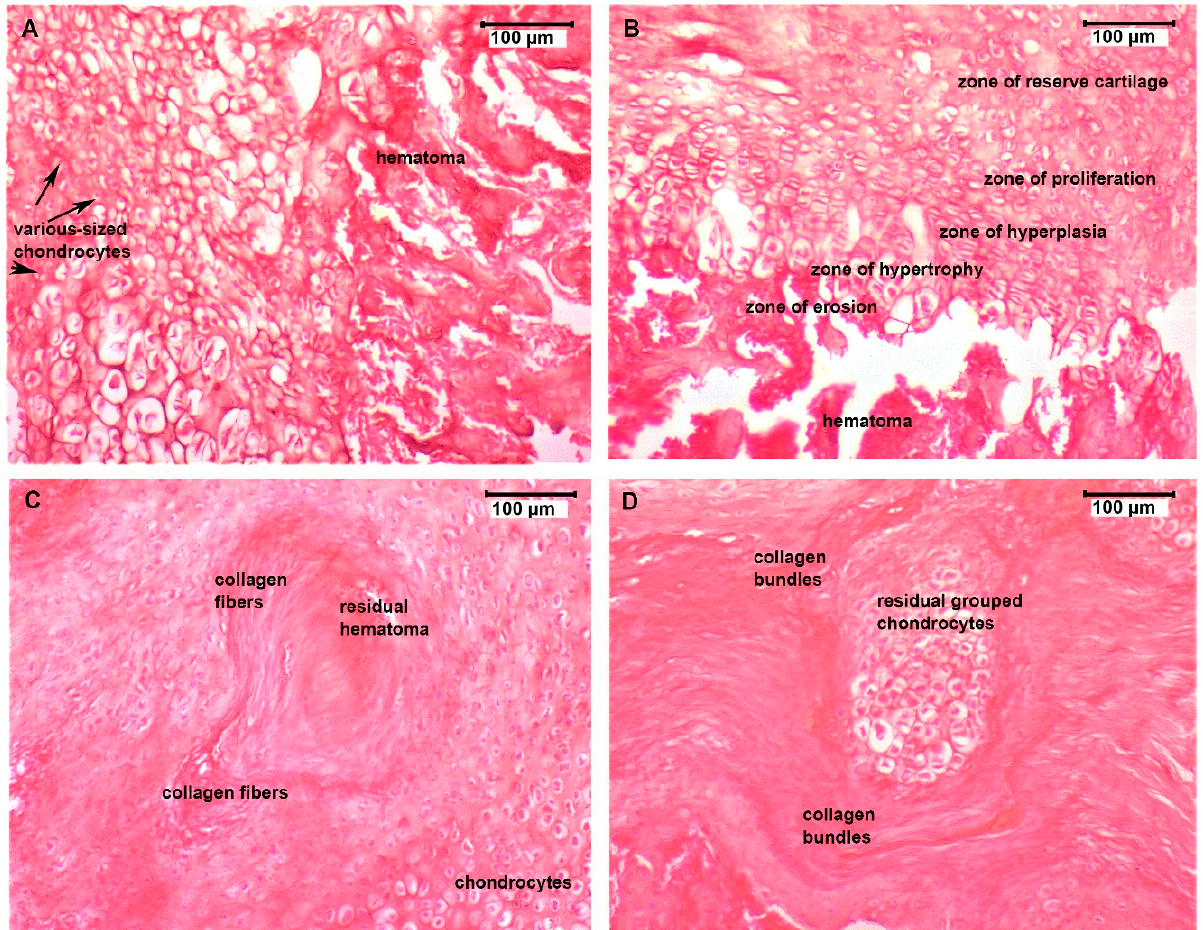
Figure 4. Optical microscopy images of H&E-stained slides of tissue samples at two weeks post surgery. ( A ) CG, 20 × , various-sized chondrocytes indicating different stages of secretion activity and a high quantity of clotted blood and inflammatory cell recruitment. ( B ) PESW group, 20 × , chondrocyte disposal is characteristic for endo-cartilaginous bone formation initiation with a zone of reserve cartilage, zone of proliferating chondrocytes, zones of hyperplasic and hypertrophic chondrocytes and a zone of erosion with an empty chondroplast hematoma was still present but to a lesser extent. ( C ) BC group, 20 × , small chondrocytes in chondroplasts that were embedded in cartilaginous matrix with a different disposition of the newly synthesized collagen fibers. ( D ) BC-PESW group, 20 × , residual grouped chondrocytes on a few microscopic fields that were contained in a large cartilaginous matrix with thick collagen bundles.